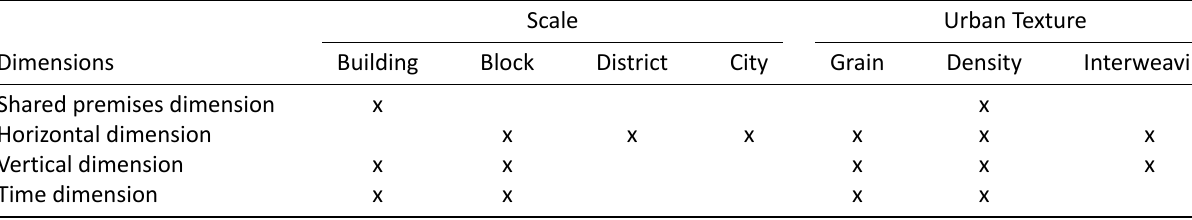
Table 1. Multidimensional typology of mixed‐use by Hoppenbrouwer and Louw (2005, p. 974): Components of mixed land use; dimensions versus scale and urban